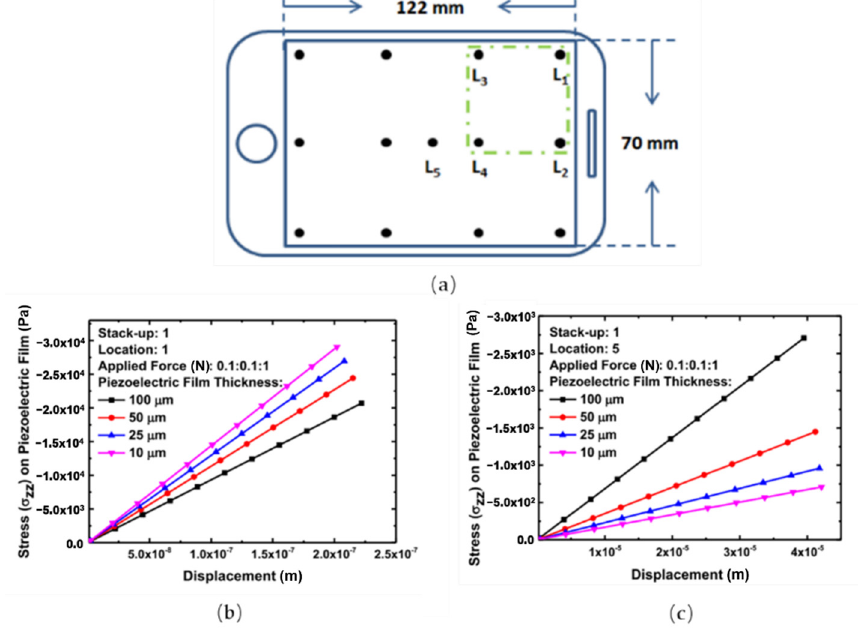
Figure 11. ( a ) The proposed touch panel and investigated touch locations; ( b ) mechanical response of Location 1; ( c ) mechanical response of Location 5 [8]. Table 3. Drawbacks of the piezoelectric touch panels and the state-of-art